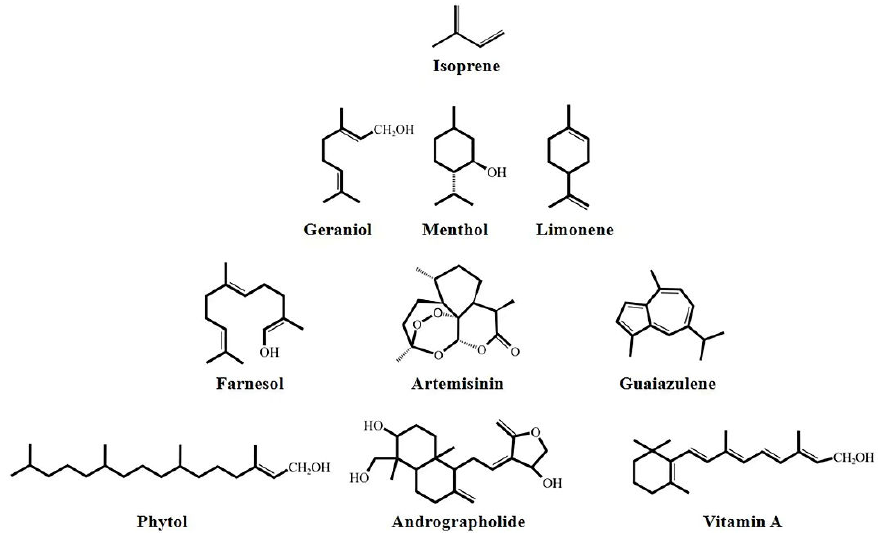
Figure 1. Chemical structure of terpenoids.